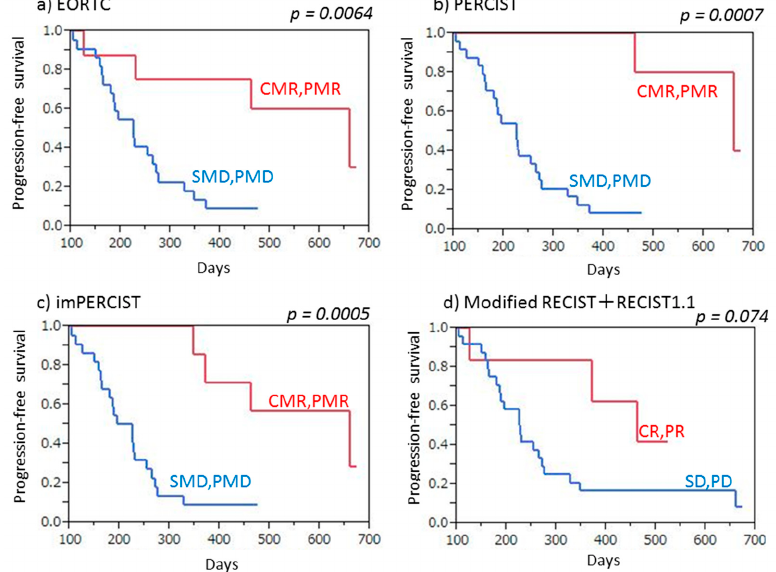
Figure 4. Progression-free survival (PFS) of malignant pleural mesothelioma patients treated by nivolumab therapy, with and without response. ( a ) EORTC demonstrated that responders (CMR/PMR) showed significantly longer PFS than non-responders (SMD/PMD) ( p = 0.0064). ( b ) PERCIST demonstrated that responders (CMR/PMR) showed significantly longer PFS than non-responders (SMD/PMD) ( p = 0.0007). ( c ) imPERCIST demonstrated that responders (CMR/PMR) showed significantly longer PFS than non-responders (SMD/PMD) ( p = 0.0005). ( d ) Combined mod- ified RECIST and RECIST 1.1 demonstrated that responders (CR/PR) tended to show longer PFS than non-responders (SD/PD), without a significant difference ( p = 0.074). 3.4. Overall Survival (OS) Nine (30.0%) of the 30 patients died from MPM after a median 14.9 months (5.8–25.6 months). Both PET (EORTC, PERCIST, imPERCIST) and CT (combined modified RECIST and RECIST 1.1) criteria indicated that patients without progression (CMR/PMR/SMD, CR/PR/SD) had a tendency for longer OS as compared to patients with PMD or PD (EORTC: p = 0.055, PERCIST: p = 0.052, imPERCIST: p = 0.089, combined modified RECIST and RECIST 1.1: p = 0.056), though the difference was not significant (Figure 5). Similarly, according to both PET (EORTC, PERCIST, imPERCIST) and CT (combined modified RE- CIST and RECIST 1.1) criteria, responders (CMR/PMR, CR/PR) showed longer OS than non-responders (SMD/PMD, SD/PD) (EORTC: p = 0.055, PERCIST: p = 0.052, imPERCIST: p = 0.053) without a significant difference, whereas CT criteria (combined mRECIST and RECIST 1.1) indicated that OS values for responders (CR/PR) and non-responders (SD/PD) were not different ( p = 0.87) (Figure 6).